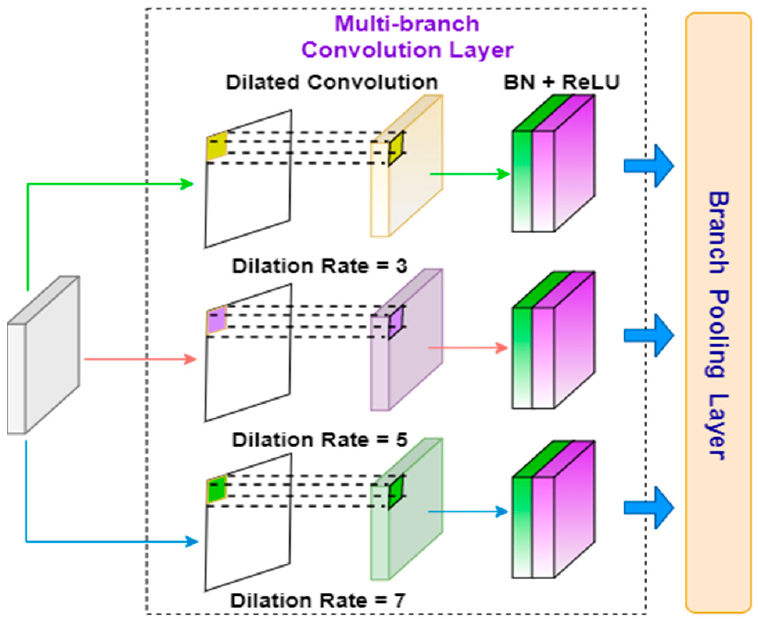
Figure 8. Attribute augmentation model.